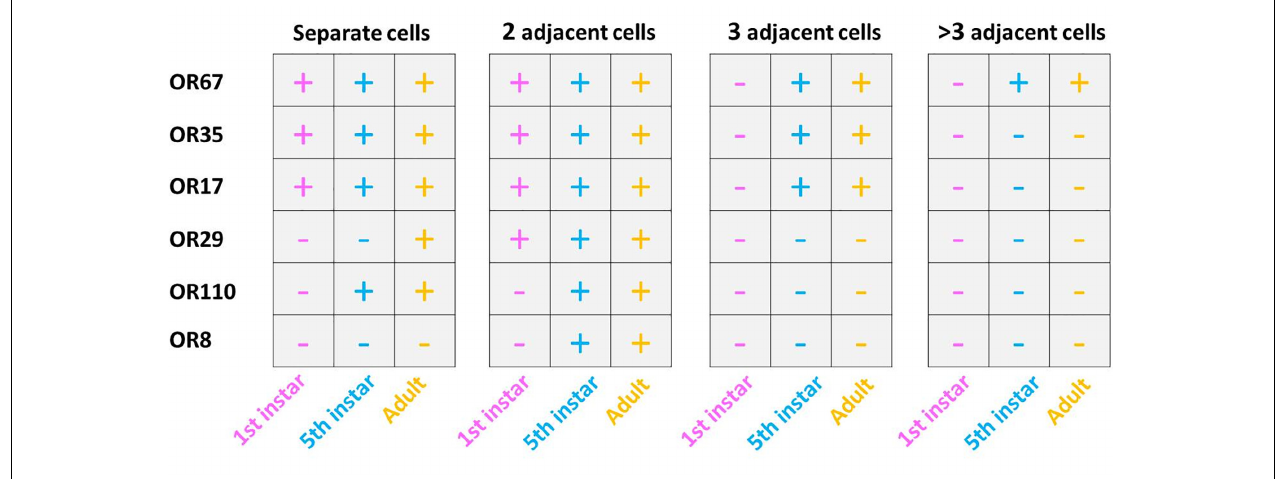
FIGURE 9 | Developmental dependent expression patterns of SgreOR’s in basiconic sensilla OSNs. Expression patterns in three developmental stages of six analyzed ORs. Observed cells and labeling patterns are indicated by a “ + ,” whereas the absence of such is indicated by “ – .” The results for this figure are based upon three independent FISH